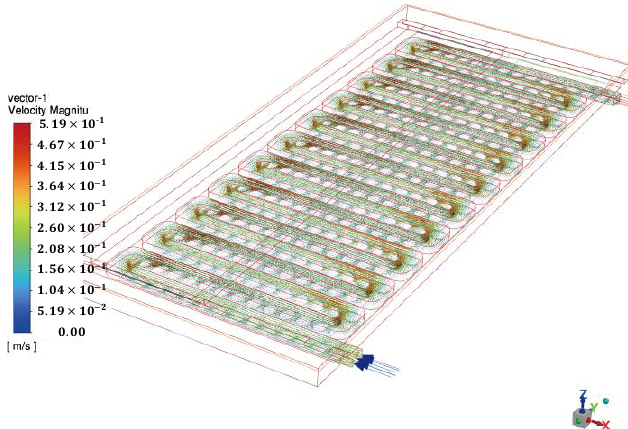
Figure 13. Liquid cooling plate flow channel fluid vector diagram. Figure 13 . Liquid cooling plate flow channel fluid vector diagram. Figure 13 . Liquid cooling plate flow channel fluid vector diagram.